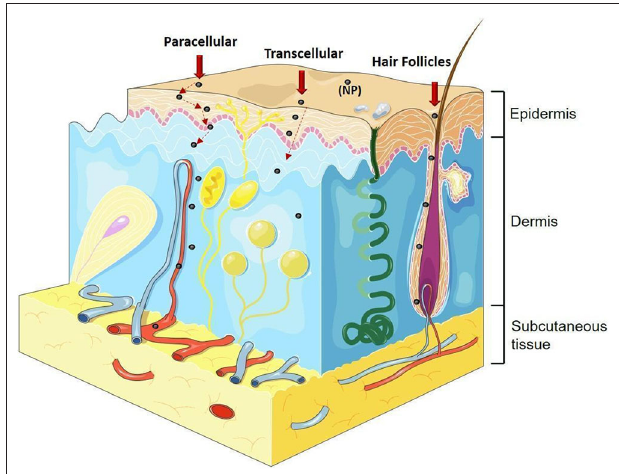
FIGURE 1 | Different pathways of nanoparticle penetration. Paracellular transport (between cells), transcellular transport (inside the cells), transport by hair follicles, sweat glands, skin folds or a combination of all. Image adapted from: